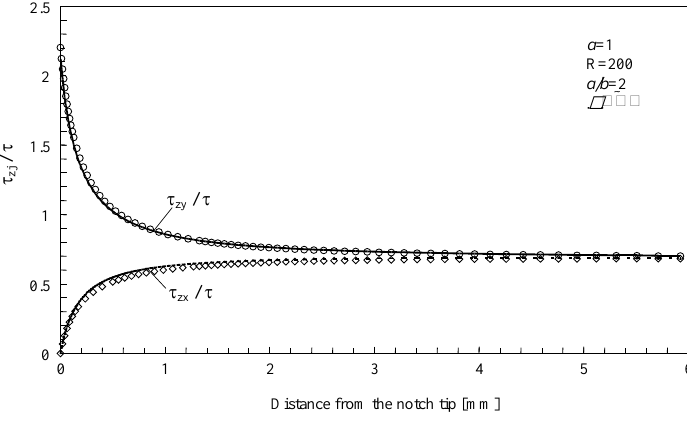
τ and τ lungo la direzione η= 0. zy zx